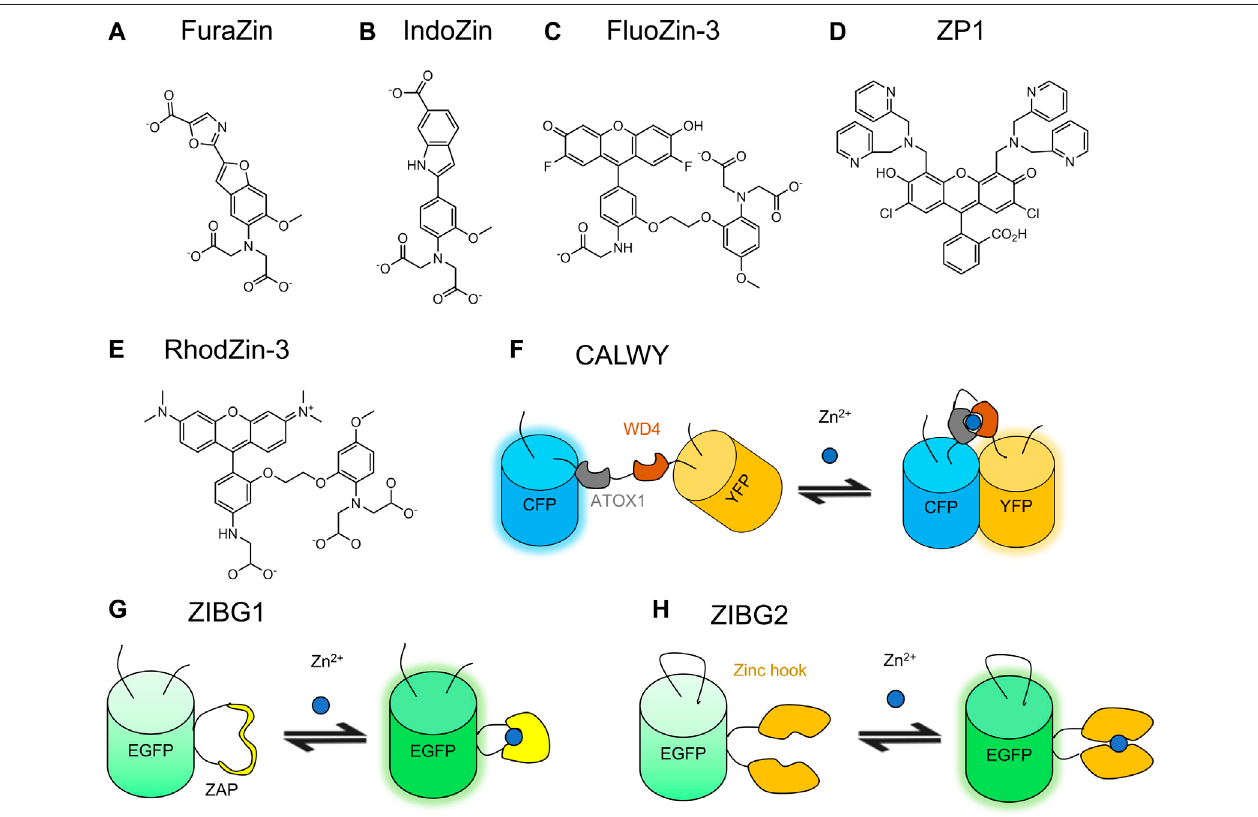
FIGURE4 | Molecularstructuresofselected small molecule-based Zn 2+ indicators and schematic representations ofselected GEZIs. Many small molecule-based Zn 2+ indicatorsarestructurallysimilar tosmallmolecule-basedCa 2+ indicators. (A) FuraZin, (B) IndoZin,and (C) FluoZin-3have fl uorophore moietiesthatareidenticalto those of fura-2 and indo-1, and fl uo-4, respectively, (Gee et al., 2002). (D) ZP1 is composed of a di-2-picolylamine (DPA) Zn 2+ chelator and a green- fl uorescent fl uoresceinmoiety(Walkupetal.,2000). (E) RhodZin-3isarhodamine-basedred fl uorescentZn 2+ indicator(Geeetal.,2002). (F) CALWY(Vinkenborgetal.,2009) is a FRET-based GEZI with the Zn 2+ binding moiety of ATOX1/WD4. (G) ZIBG1 (Chen et al., 2019) is based on the Zn 2+ binding ZAP1 protein and ncpEGFP. (H) ZIBG2 (Chen et al., 2019) is based on Zinc hook and cpEGFP.